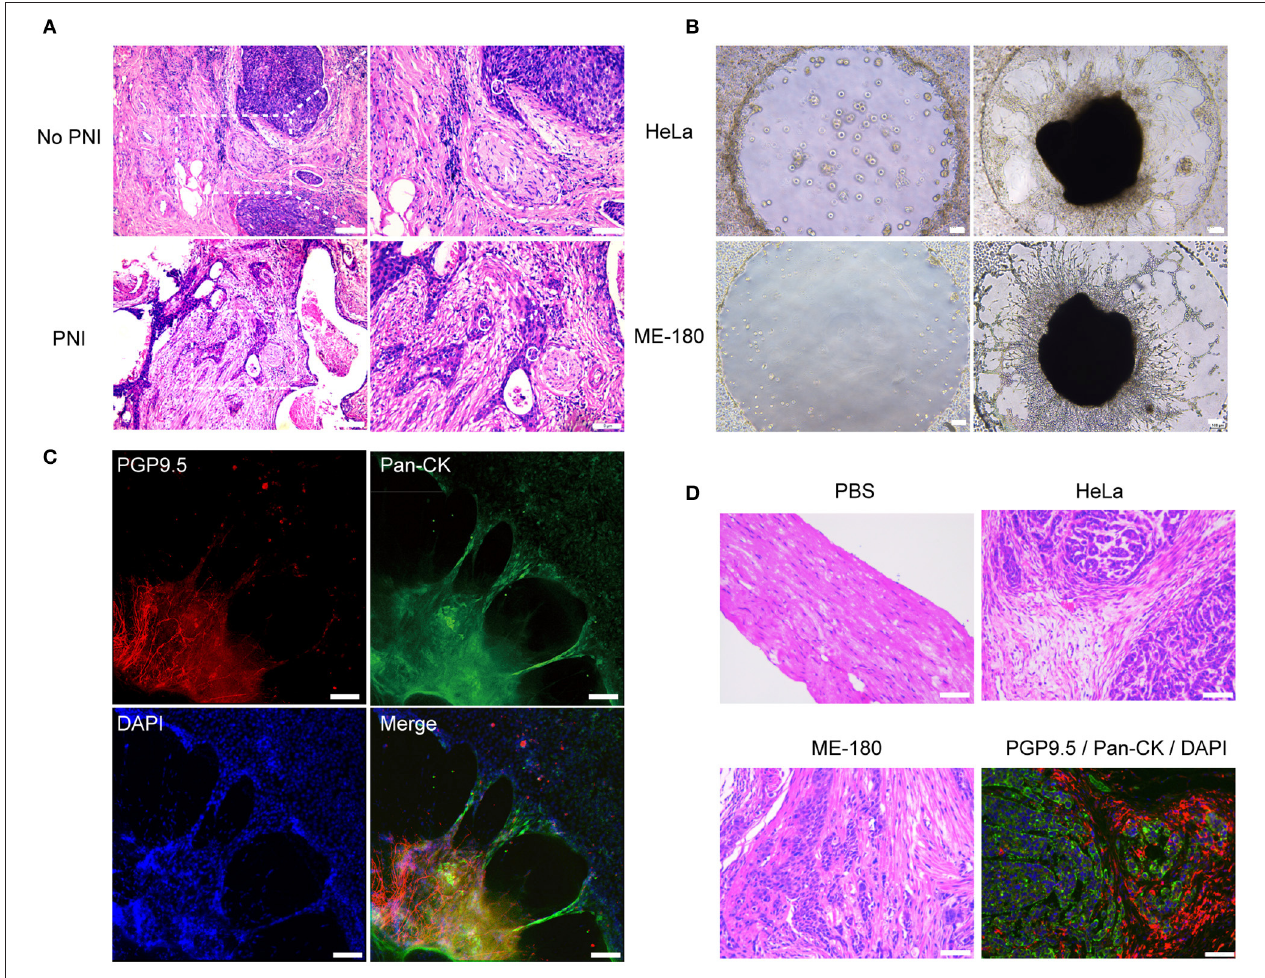
FIGURE 1 | The presence of perineural invasion in vitro and in vivo . (A) Hematoxylin and eosin (HE) stained image of non-PNI and PNI cervical cancer tissues. The area of nerves is marked by a dashed line. N refers to nerves and C refers to cancer cells. (B) Cervical cancer cell lines, HeLa and ME-180, induced PNI in an in vitro model. DRG was placed in the center of Matrigel (50 × magnification, scale bar, 100 µ m). (C) Double immunofluorescence staining of neurites and HeLa cells in the perineural niche. Staining: PGP9.5, pan-cytokeratin (pan-CK), DAPI, and overlay respectively (100 × magnification, scale bar, 100 µ m). (D) H&E stained image of sciatic nerves injected with PBS, HeLa and ME-180, respectively. Image in the right refers to double immunofluorescence staining of sciatic nerve (PGP9.5) and HeLa cells (pan-CK) (200 × magnification, scale bar, 50 µ m).